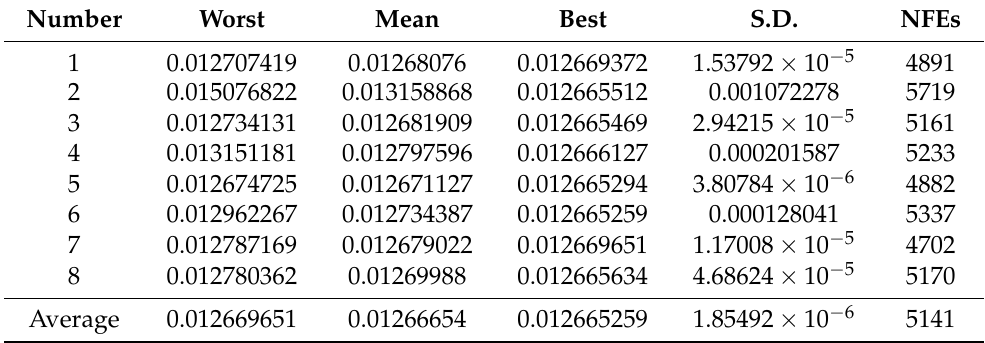
Table 6. Statistical results for the tension/compression spring problem by adaptively integrated swarm intelligence-metamodelling